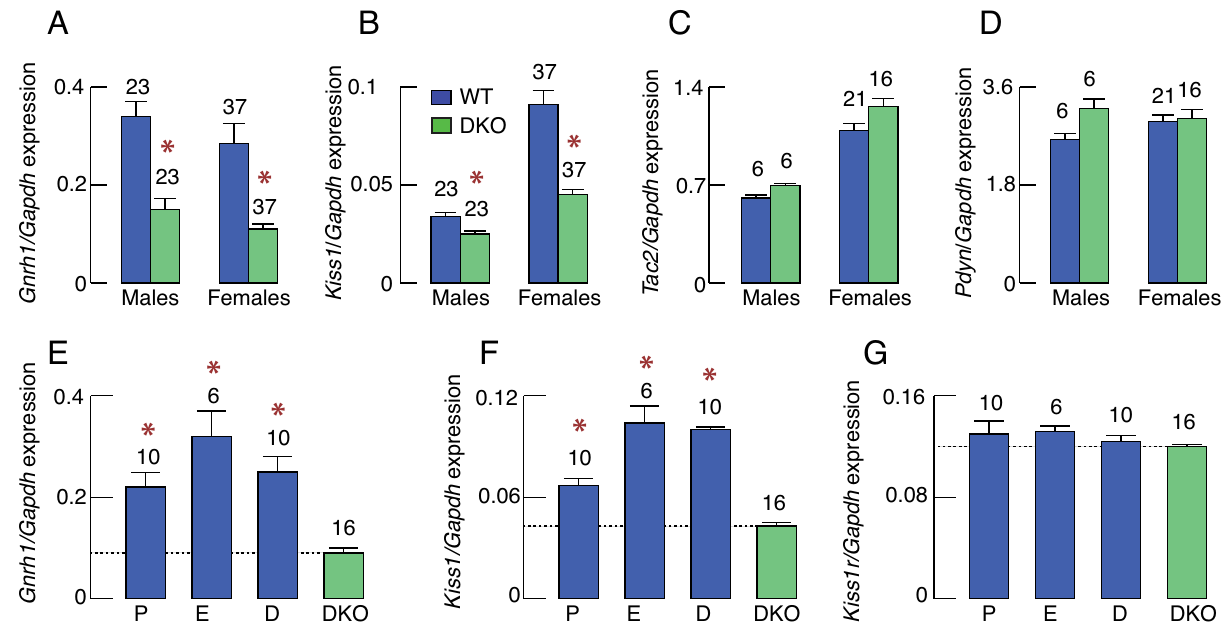
Figure 6. Selective effects of DKO on gene expression in the hypothalamus. ( A – D ) Gene expression in neurons that contribute to GnRH pulse generator : Gnrh1 (A), Kiss1 (B), Tac2 (C), and Pdyn (D). ( E – G ) Comparison of gene expression in WT females at different stages of the estrous cycle and DKO females: Gnrh1 (E), Kiss1 (F), and Kiss1r (G). Bars shown are mean ± SEM values; numbers above bars indicate number of replicates; asterisks, P < 0.01 between pairs or between DKO and control proestrus (P), estrus (E), and diestrus